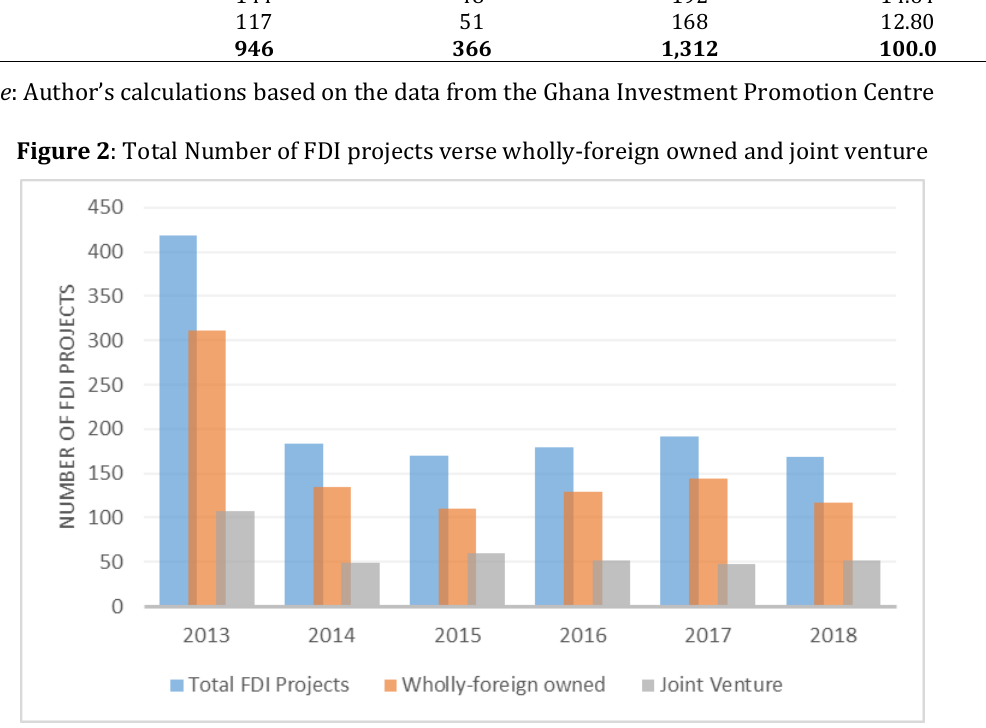
Source : Author’s calculations based on the data from the Ghana Investment Promotion